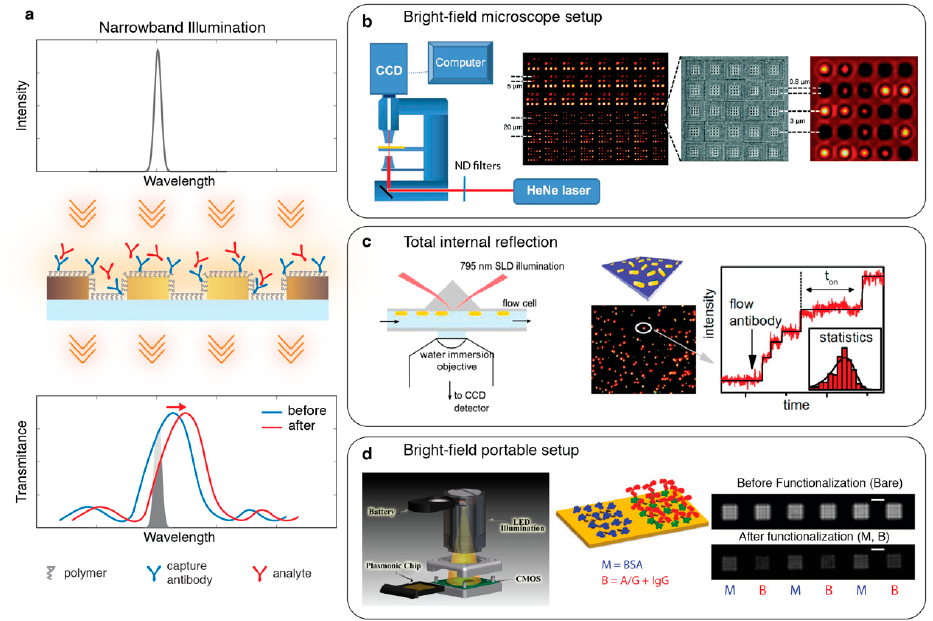
Figure 6. ( a ) Intensity interrogation of nanophotonic sensors. In this representative schematic a collinear light-path is shown, where narrowband illumination is tuned to a flank of the resonance peak in transmission. The red-shift in the spectral position of the resonance peak induces a change in transmission, which can be monitored to extract quantitative analyte binding information; ( b ) (left) Bright-field transmission configuration used for high throughput intensity interrogation. (middle to right) Bright-field image of a large microarray of sensing pixels, which are composed of a set of nanohole arrays with varying periodicity surrounded by Bragg mirrors, scanning electron microscope (SEM) image of the sensor, bright-field image of a single sensing pixel. Reproduced with permission from [77,78] Copyright 2008 Optical Society of America and Copyright 2009 The Royal Society of Chemistry; ( c ) (left) total internal reflection configuration used to monitor stochastic protein interactions from hundreds of single-molecule plasmonic sensors. (right) Time-traced scattering intensity of individual nanoparticles, stepwise intensity changes show stochastic single antibody binding events. Adapted with permission from [83]. Copyright 2015 American Chemical Society; ( d ) (left) schematic of a portable biosensing device used for computational imaging of Au nanohole arrays. (right) Formation of protein layers result in intensity decrease as shown in the bright-field images. Adapted with permission from [84] Copyright 2014 Nature Publishing Group.